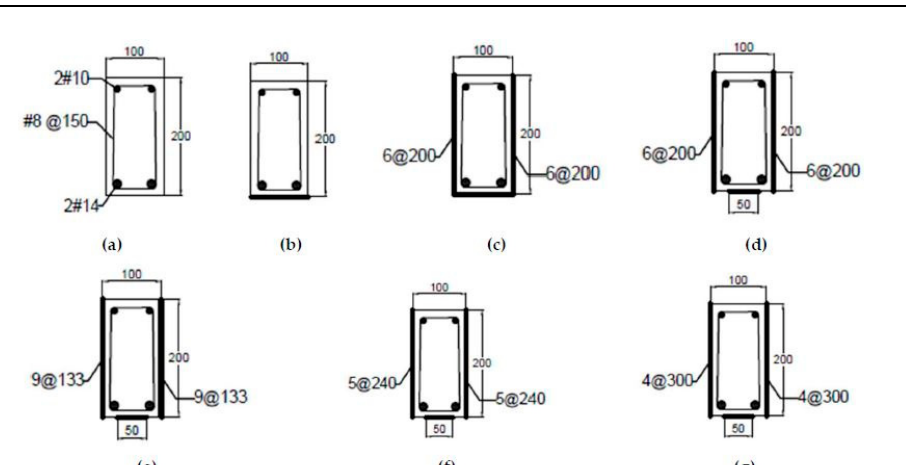
Figure 1. Cross-section details of test specimens: ( a ) Control samples, ( b ) B1 (F+0), ( c ) B2 (F+S), ( d ) B3 (F+S), ( e ) B4 (F+S), ( f ) B5 (F+S), and ( g ) B6 (F+S).